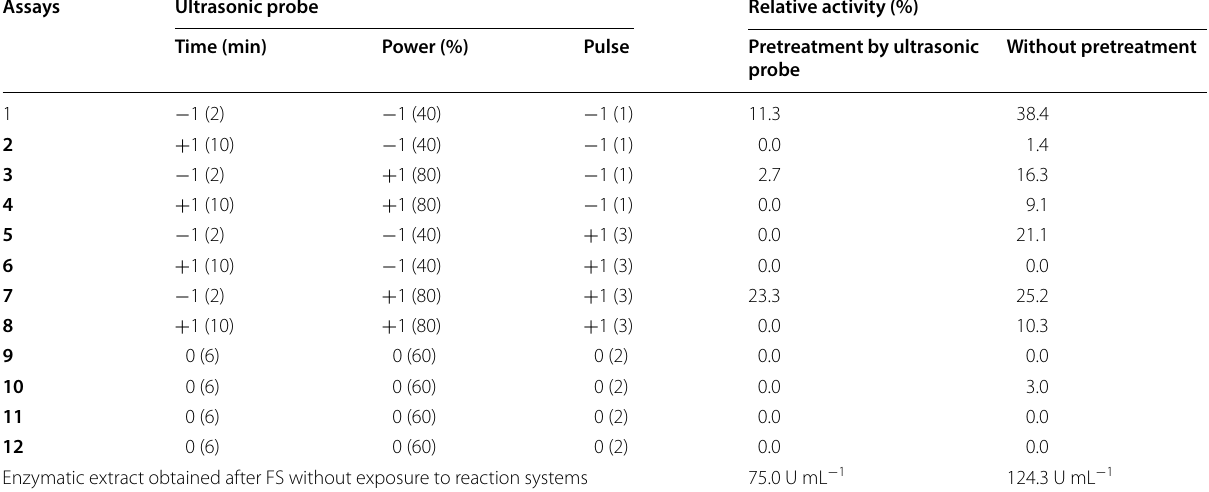
Table 3 Experimental planning matrix (real and coded values) and relative activity results (%) for the conditions evaluated in the reaction system ultrasonic probe with enzymatic extracts produced from swine hair pretreated by ultrasonic probe and without